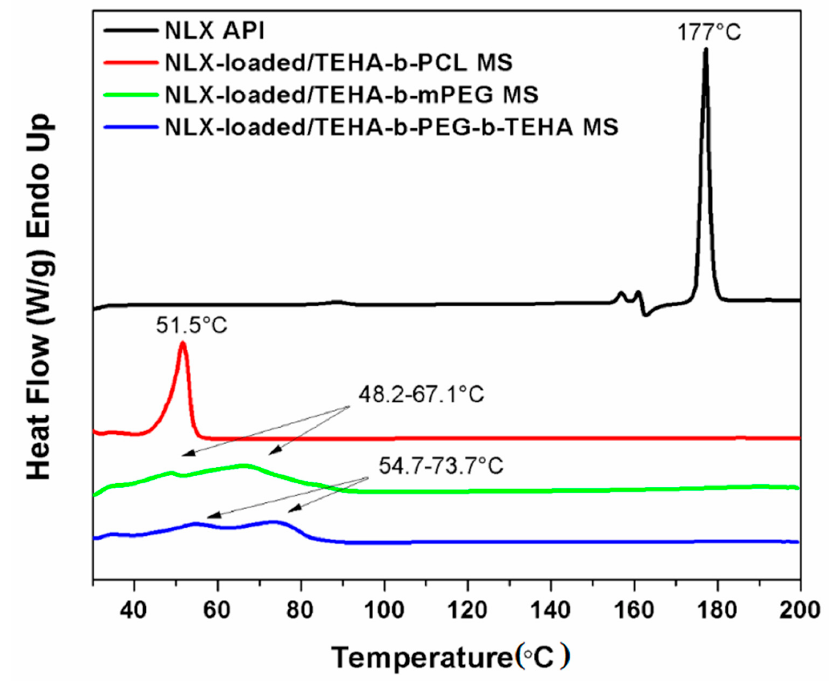
Figure 7. DSC thermograms of NLX API, NLX-loaded TEHA-b-PCL, NLX-loaded/TEHA-b-mPEG, and NLX-loaded TEHA-b-PEG-b-TEHA microspheres.